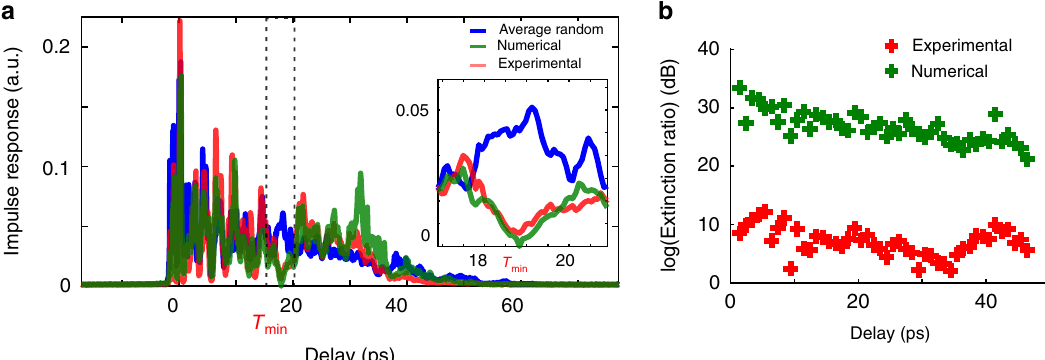
Fig. 2 Enhancing light intensity at a chosen delay time over all the spatial and polarization modes of a multimode fi ber. a Enhancing light intensity at τ ¼ 8 : 7 ps. Blue: time of fl ight distribution of the multimode fi ber. Red: experimental impulse response of the eigenstate maximizing the light intensity at max τ max . Green: numerical propagation of this eigenstate with the experimentally measured MSTM. Inset: zoom around τ max for the two polarization states for the eigenstate (top row) and a random combination of modes (bottom row). b Enhancement ratio delay times. Red: enhancement ratios calculated with the experimentally measured impulse responses. Green: enhancement ratios calculated with the numerically propagated impulse responses